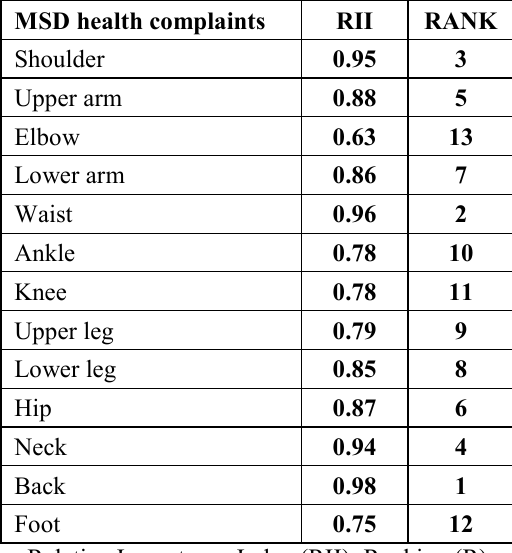
Table 5. Self-Reported MSD Health